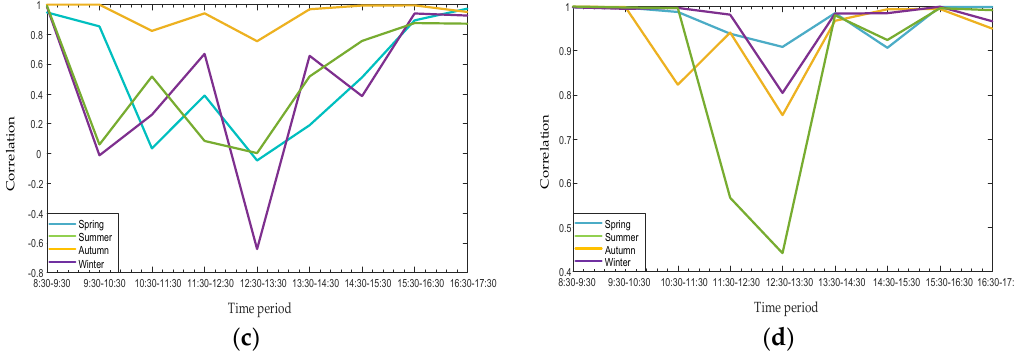
Figure 3. ( a ) Correlation between PV power and air temperature; ( b ) Correlation between PV power and relative humidity; ( c ) Correlation between PV power and diffuse horizontal radiation; ( d ) Correlation between PV power and global horizontal radiation.